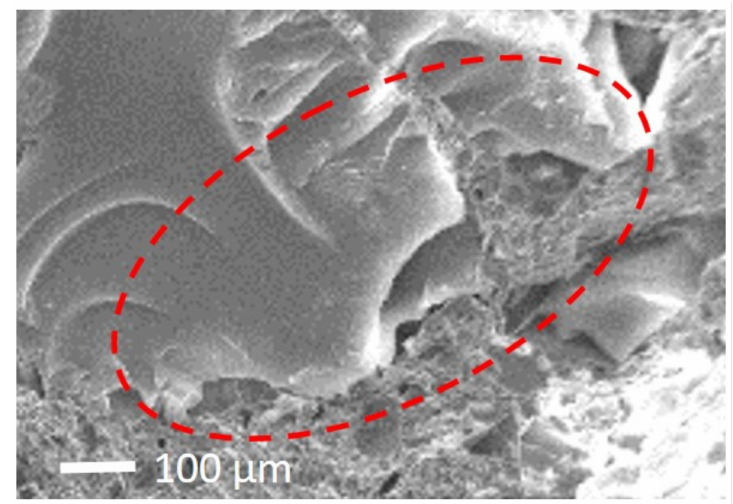
Figure 6. SEM image of C(SA) render.